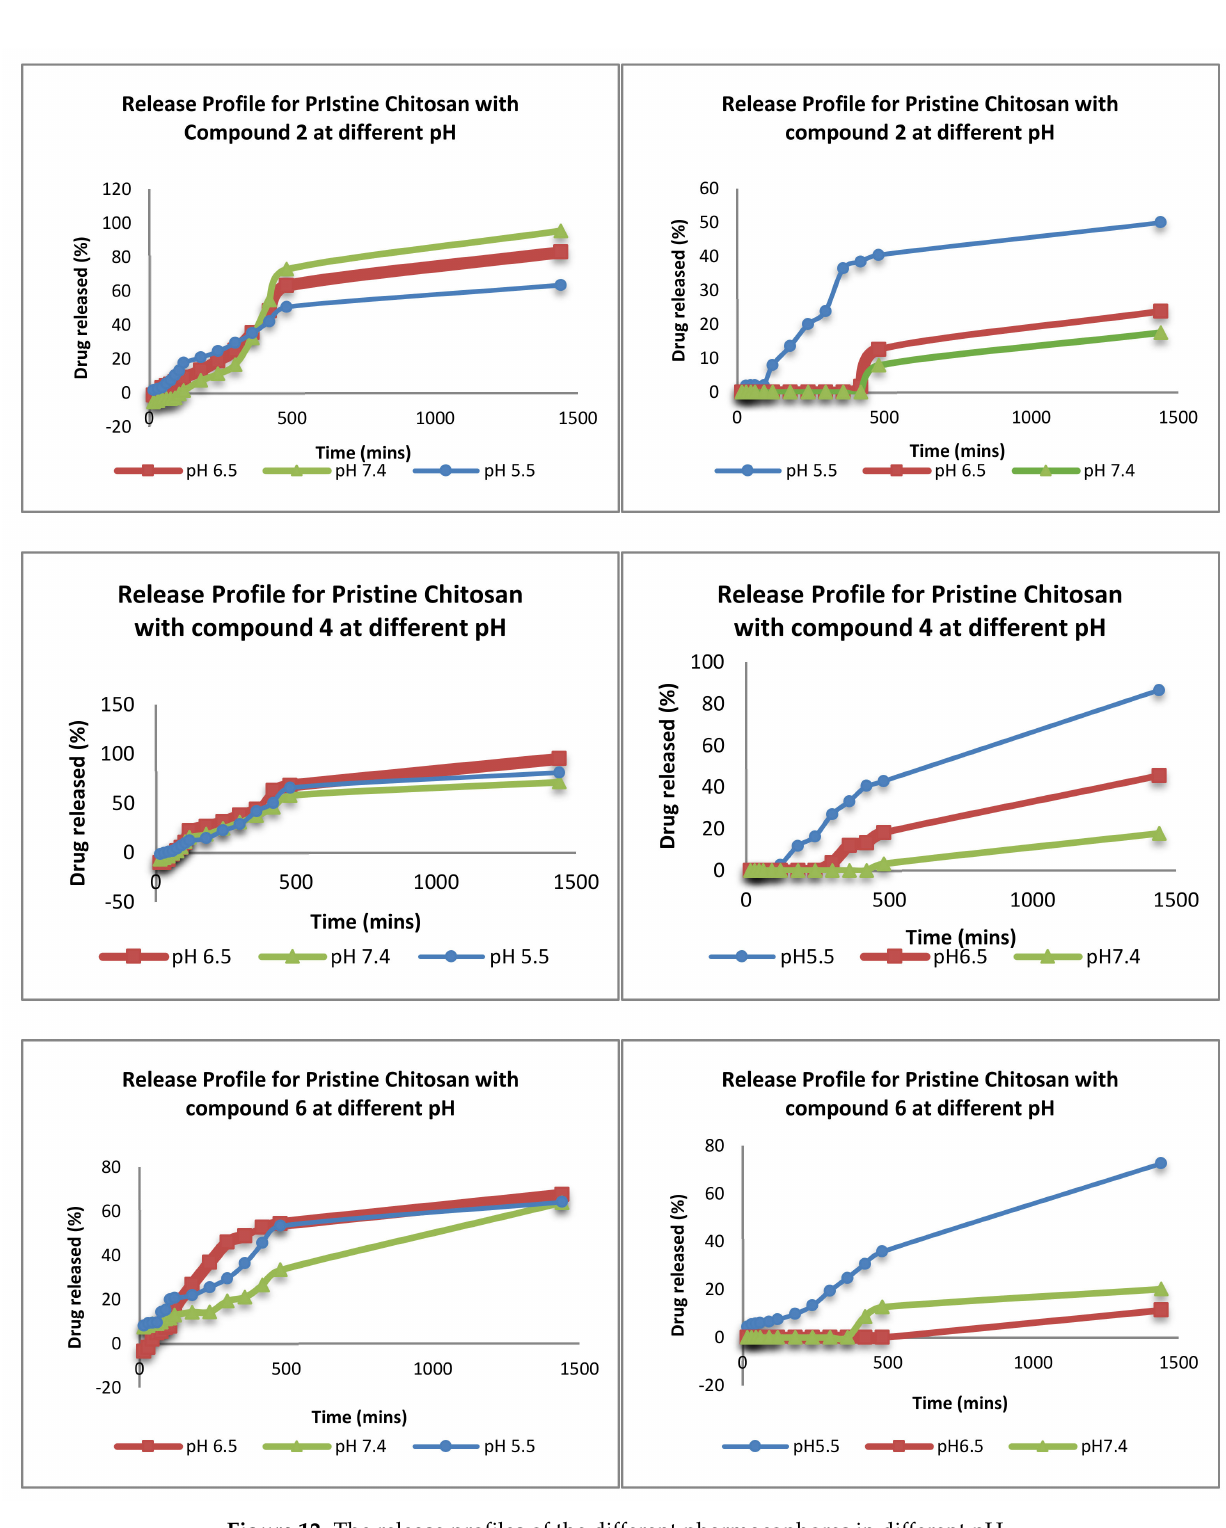
Figure 12. The release profiles of the different pharmacophores in different